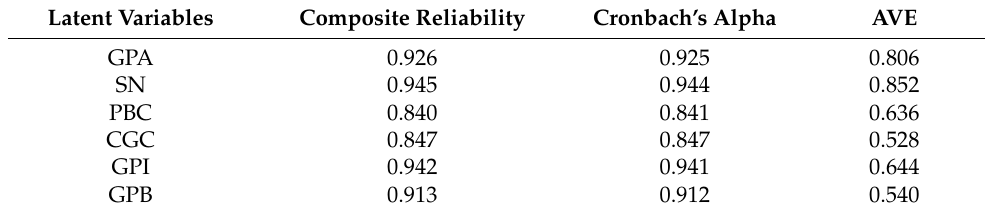
Table 2. Convergent validity and internal consistency